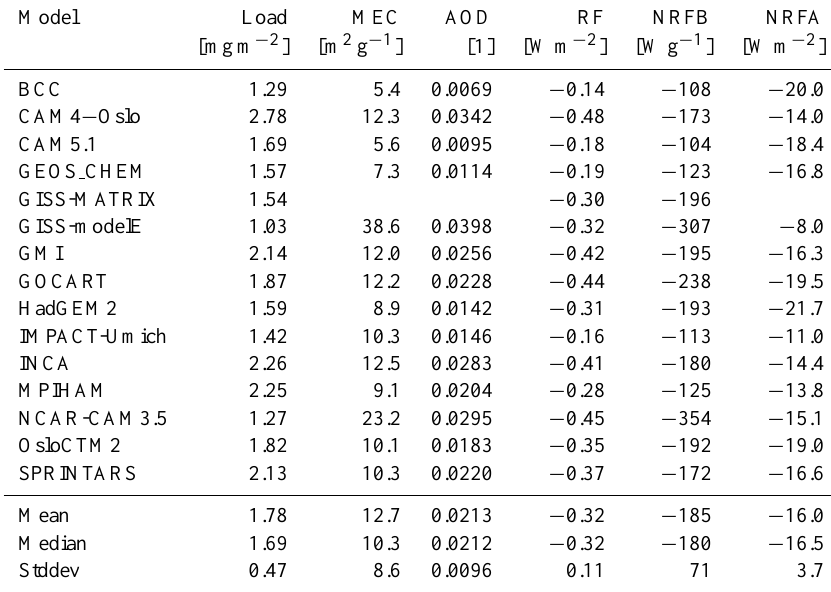
Table 4. Anthropogenic load, mass extinction coefficient (MEC), AOD, RF, normalized RF with respect to burden (NRFB), normalized RF with respect to AOD (NRFA) for